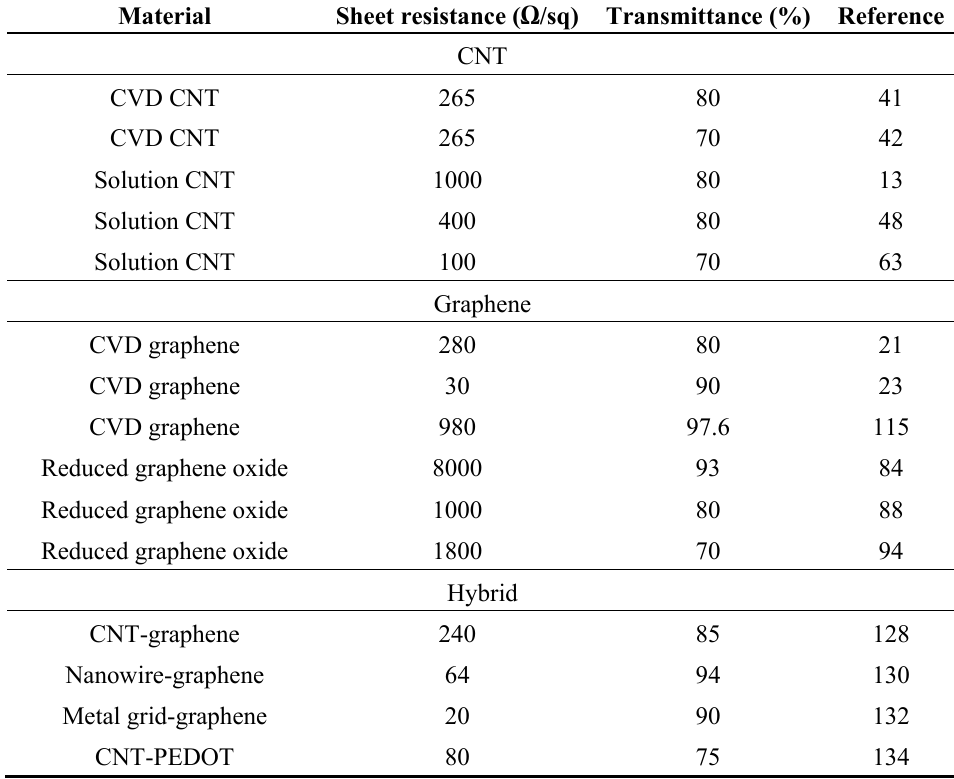
Table 1. Sheet resistance and optical transmittance of different carbon nanomaterials and their